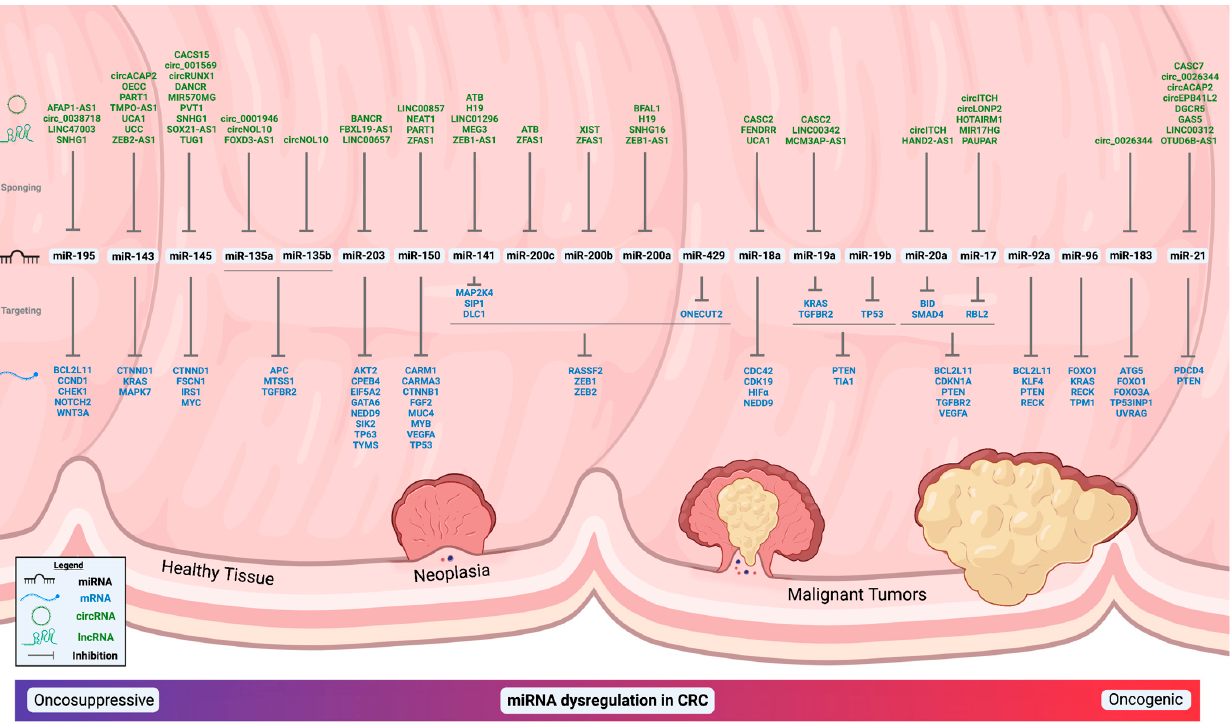
Figure 1. Dynamic relationships between miRNAs and ceRNAs and their connection to CRC . The miRNAs are listed in general/relative order of oncosuppressive to oncogenic in CRC from left to right with miRNA with dual natures being more central. All miRNAs, “sponging” ceRNAs (circRNA and lncRNA), and mRNAs listed have references cited within the main text and/or tables.